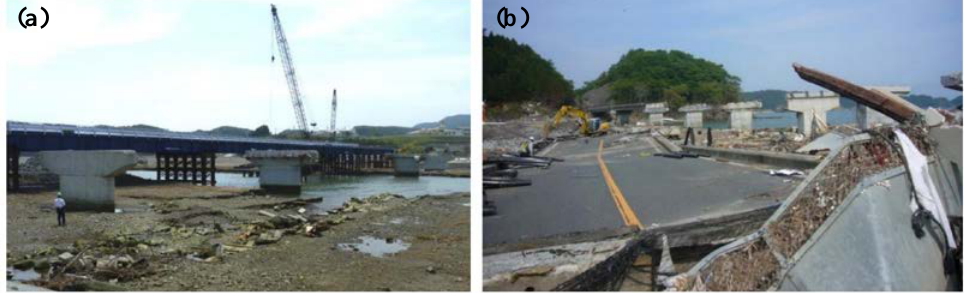
Figure 1. Damaged bridges after the 2011 Great East Japan Earthquake: ( a ) Koizumi bridge on the left (photo: E. Monzon) and (b) Utatsu Bridge on the right (photo: I. G. Buckle).